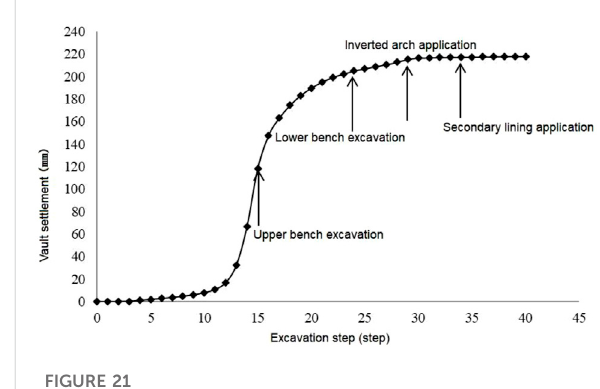
FIGURE 21 Variation pattern of the vault settlement of the surrounding rock with tunnel excavation steps.